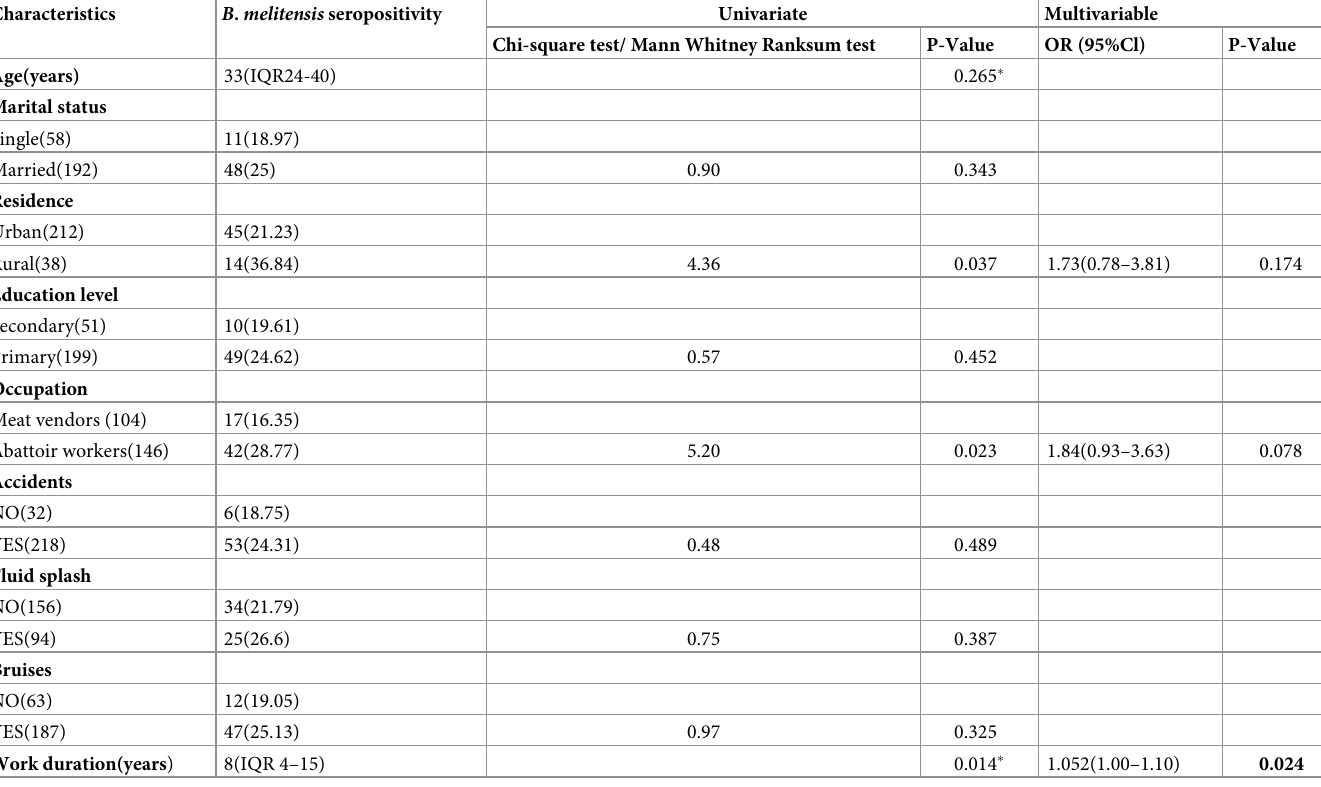
Table 3. Factors associated with B . melitensis seropositivity among study participants between May and July 2017.